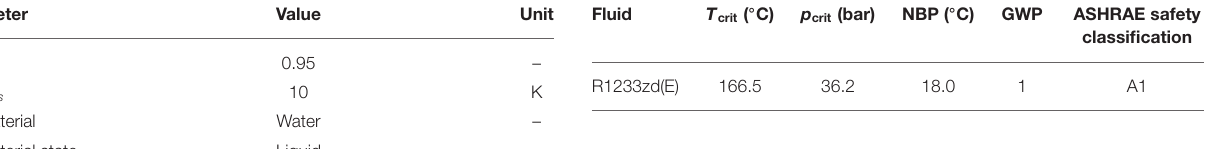
TABLE 3 | TES technical and operational parameters. Parameter